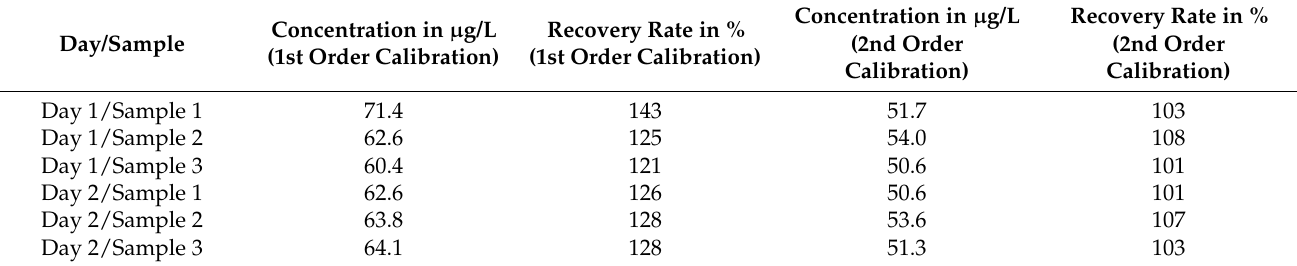
Table 5. Determined platinum concentrations and recovery rates for test samples containing 50.0 µ g/L platinum (in a 200.0 µ g/L platinum “blank”, see text above) measured with a bismuth film on screen- printed electrode.